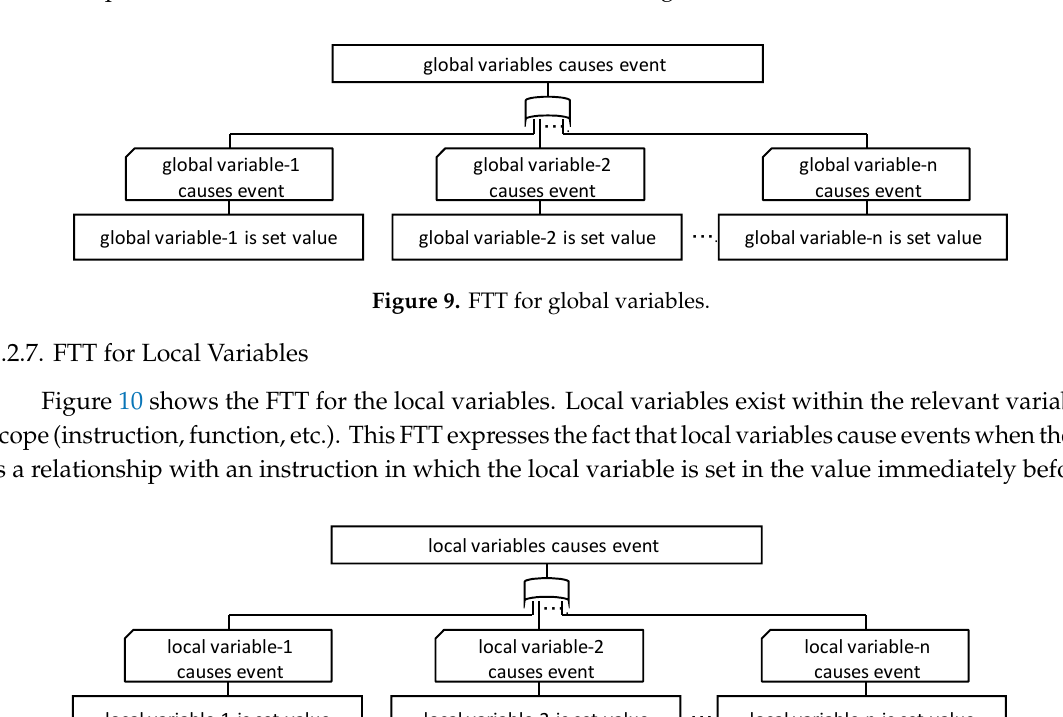
Figure 8. FTT for interrupt.